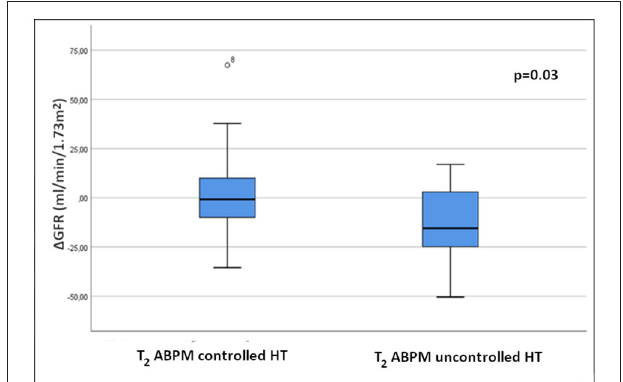
FIGURE 2 | Comparison of changes in GFR between controlled and uncontrolled hypertensive patients at the second follow-up. 1 GFR, GFR difference between T2 and T1 (T2 GFR - T1 GFR